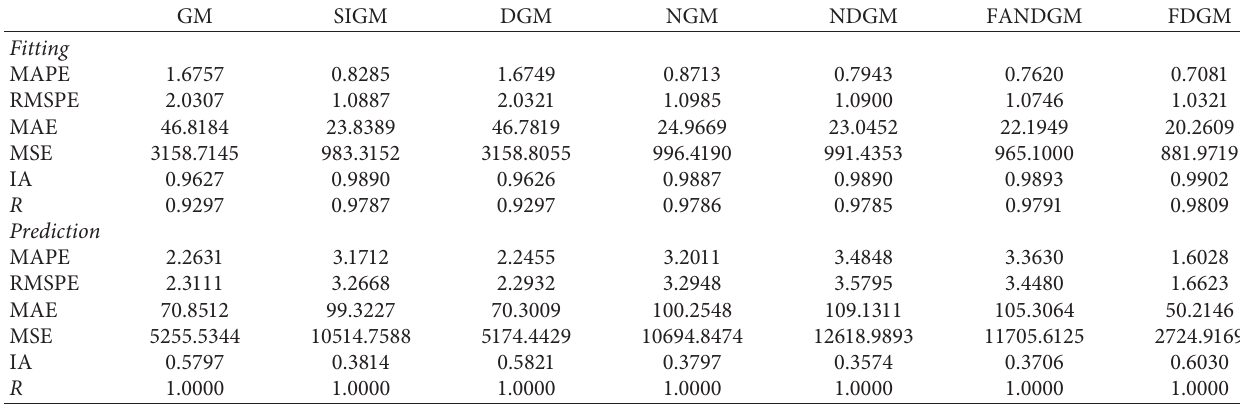
Table 7: Error metrics of energy consumption of civil building in Beijing.